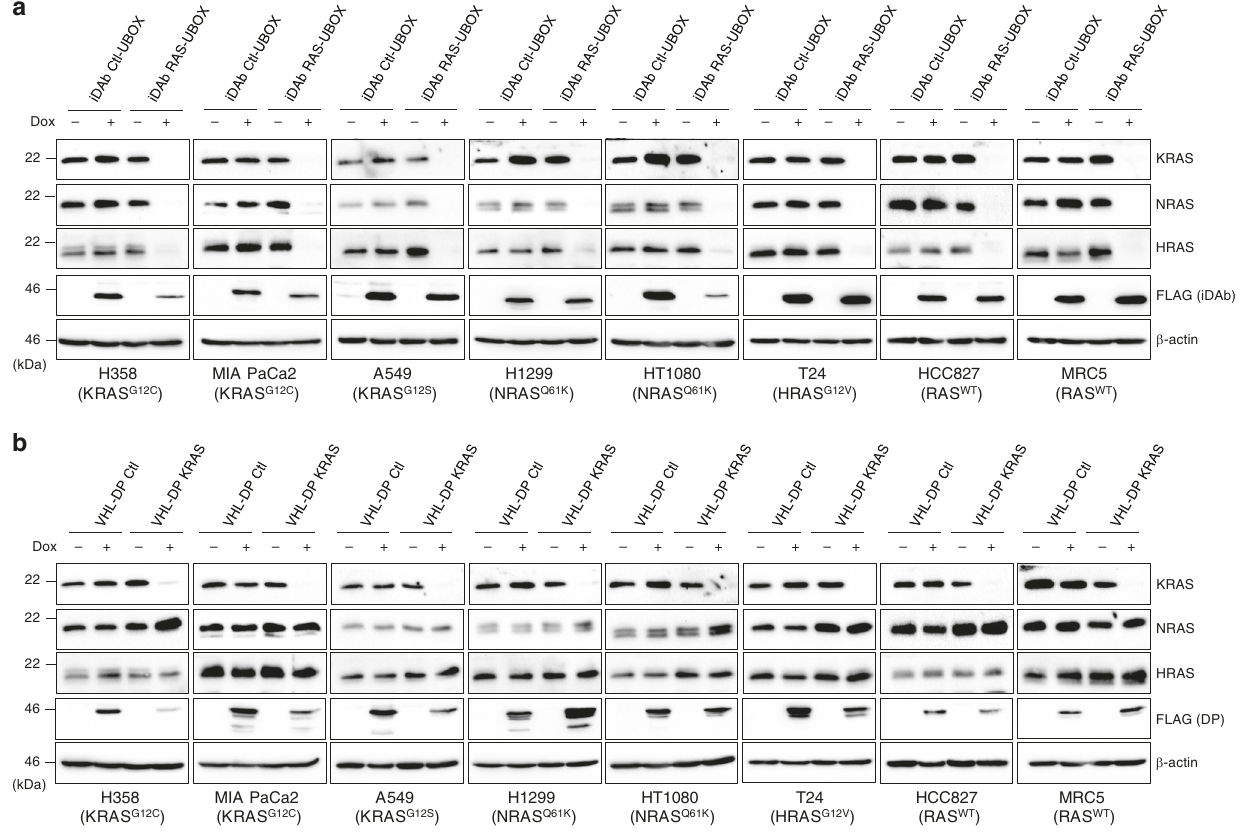
(Fig. 3a) or degradation of KRAS only when the KRAS degrader was expressed (Fig. 3b). This occurred in all the cell lines tested. KRAS degrader inhibits RAS signalling of mutant KRAS cells .